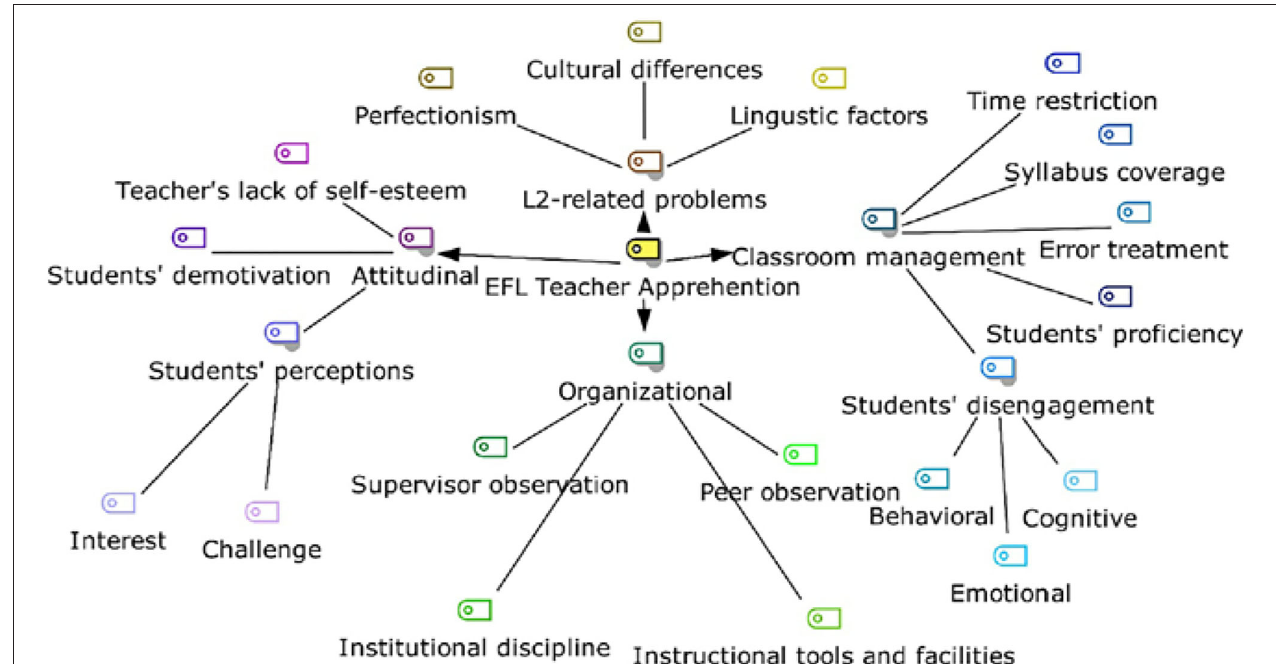
FIGURE 1 | The model of the ramifications of teachers’ apprehension (Goldast et al., 2021, p.